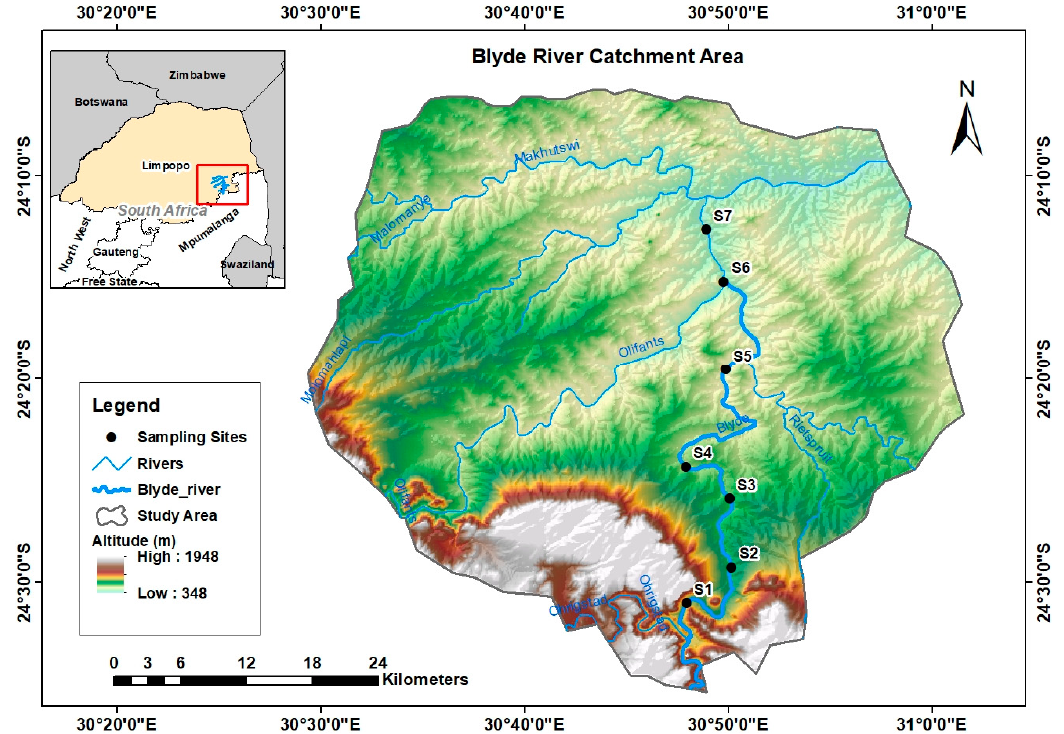
Figure 1. Map of the study area, showing the locations of the seven sampling sites of the Blyde